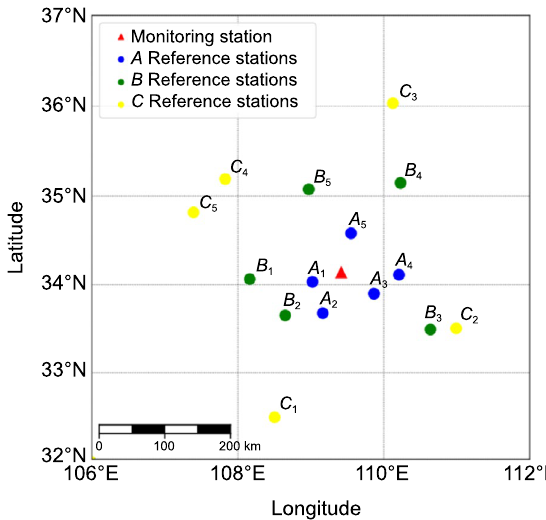
Fig. 1 Distribution of the landslide monitoring station and reference stations